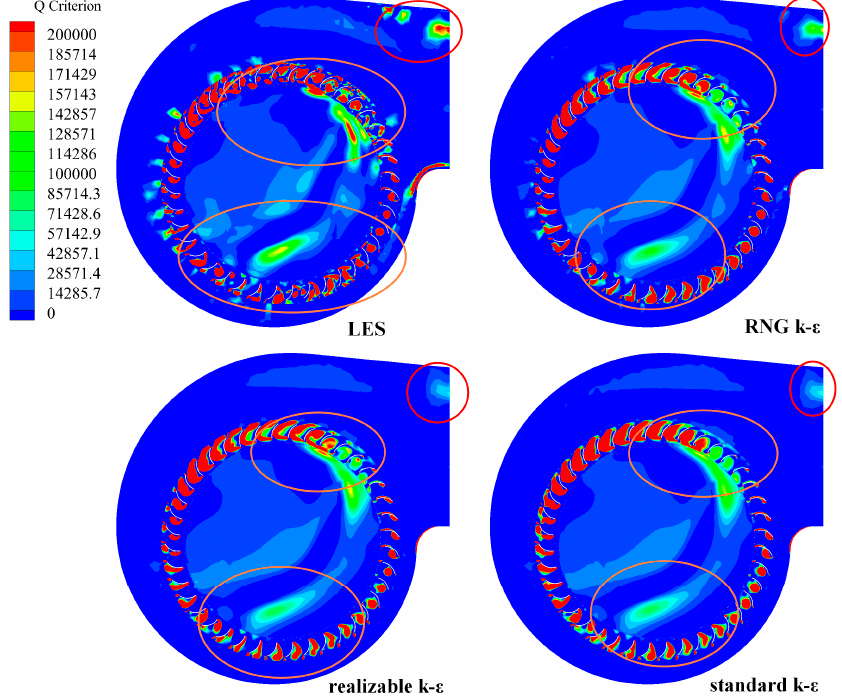
Figure 5. Q value distribution between Large Eddy Simulation and Reynolds-averaged Navier–Stokes Equations method (RANS) at the same computing time t = 0.0125 s.